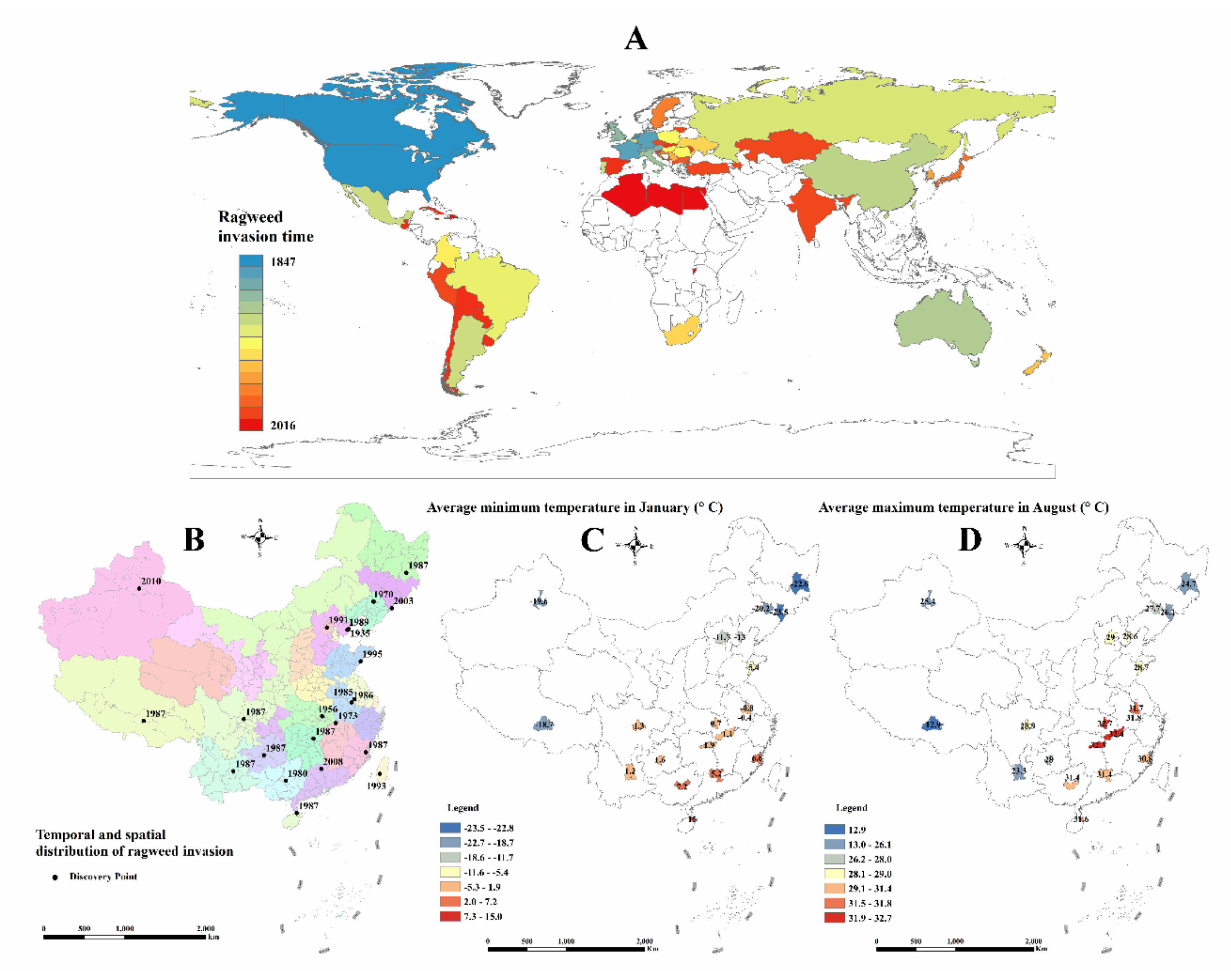
Figure 1. The geographical distribution and time scale of the invasion of the common ragweed in the world ( A ) and in China ( B ), and the mean low ( C ) and high temperatures ( D ) of the invaded habitats in China (2010–2018)